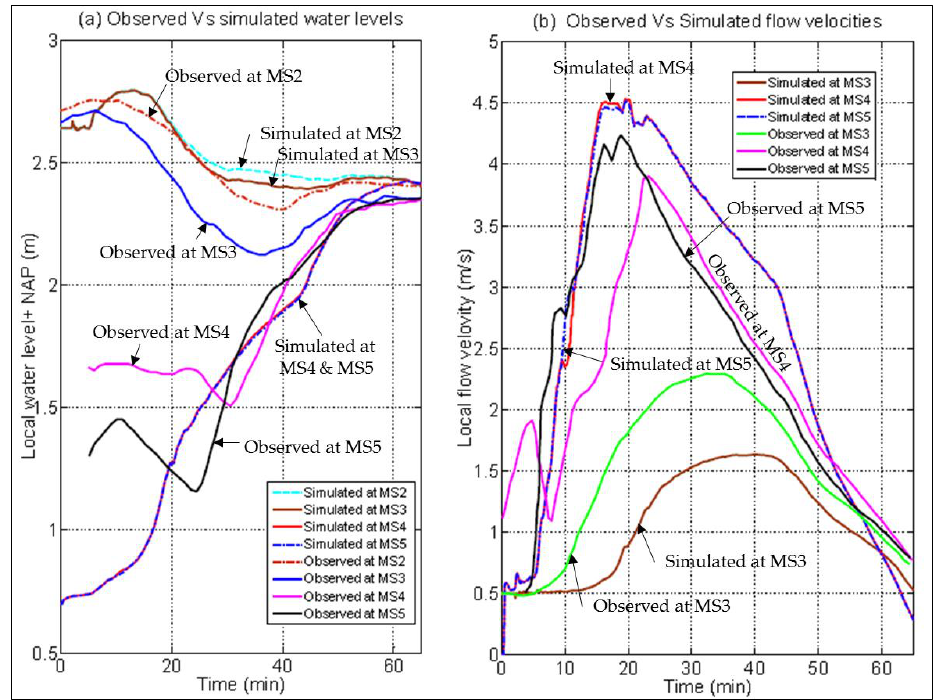
Figure 19. Observed vs modelled, by XBeach, ( a ) water depths and ( b ) flow velocities at different measuring stations in Figure 4b.